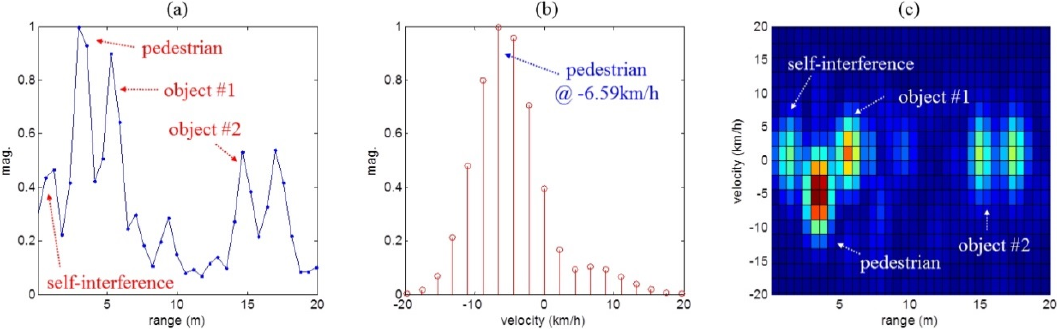
Figure 8. Cont. Figure 8. Cont